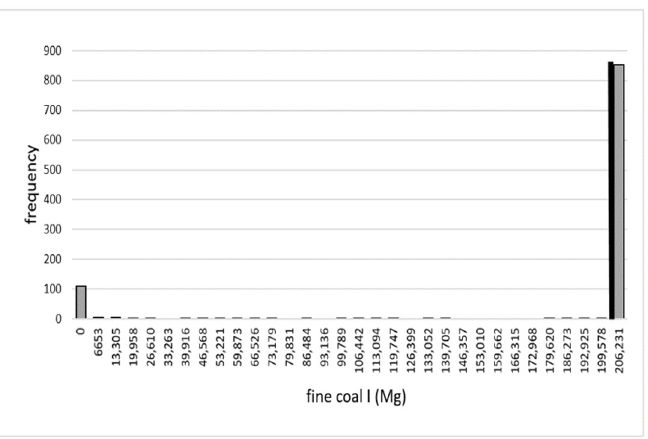
Figure A16. Histogram showing frequencies of achieving given quantity of sales of fine coal I for mine “E” with σ yprog .